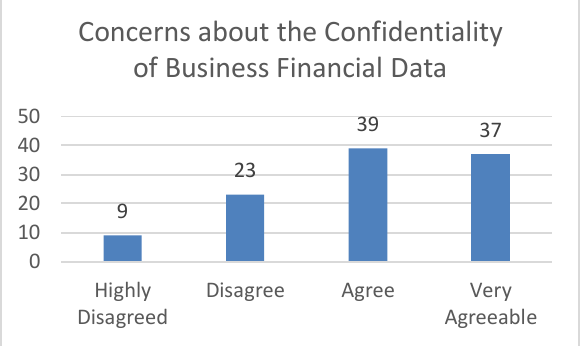
Figure 2: Concerns over the confidentiality of Business Financial Data; Source: Own